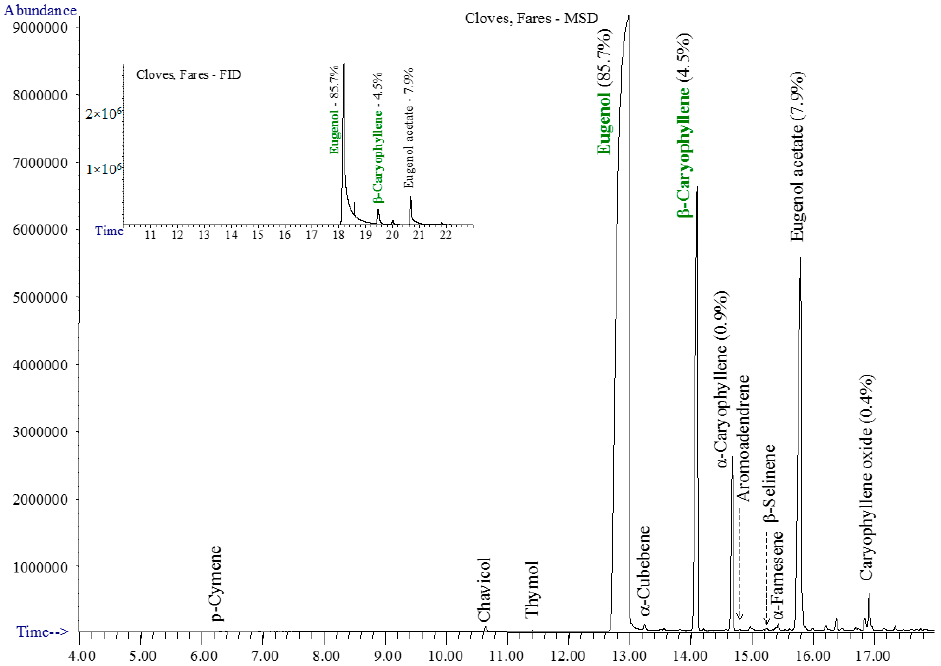
Figure 2. The GC-MSD and GC-FID (insert) chromatograms of clove oil.